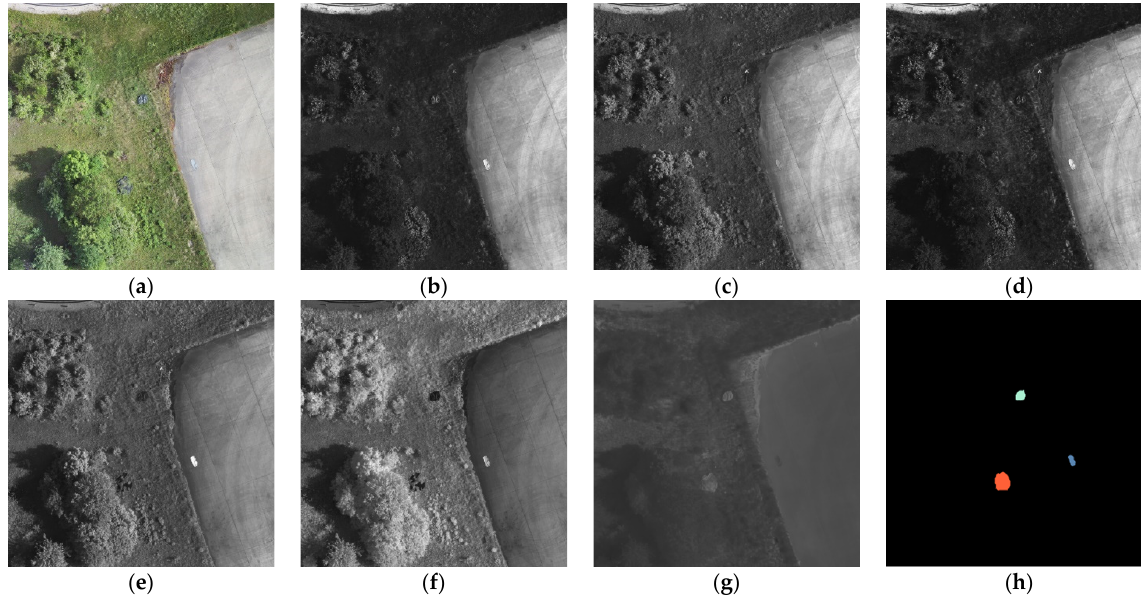
Figure 1. Single sample of MUCAD containing three different targets (grey tarpaulin, green tarpaulin, and 2D camouflage net). ( a ) VIS; ( b ) blue; ( c ) green; ( d ) red; ( e ) EIR; ( f ) NIR; ( g ) LWIR; ( h ) ground truth. The grey tarpaulin, green tarpaulin, and 2D camouflage net are labeled as dark blue, light blue, and red, respectively.